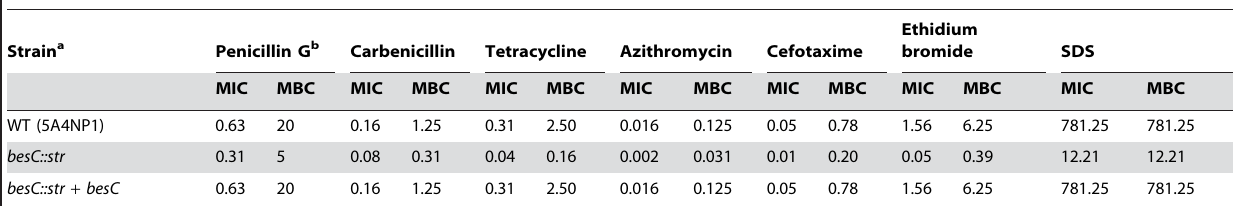
Table 1. In vitro antibiotic susceptibility of B. burgdorferi .